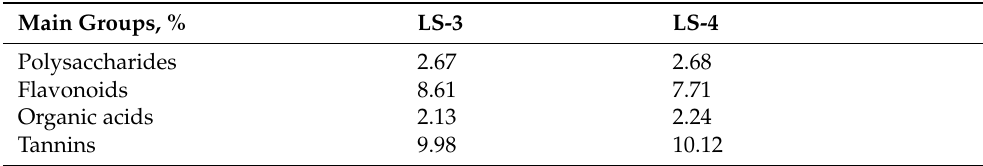
Table 4. Comparative quantitative content of biologically active compounds in LS-3 and LS-4 extracts from S. sclarea L.